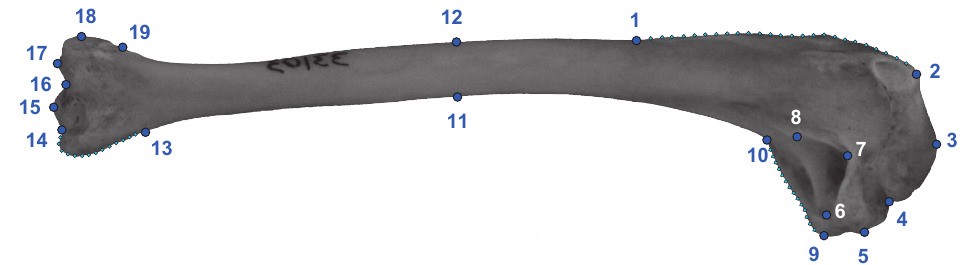
Figure 3. Humerus of Oxyura jamaicensis in caudal view showing the location of the 19 landmarks and the 3 strings of semilandmarks used in this study. Landmarks are described in the Table S2.